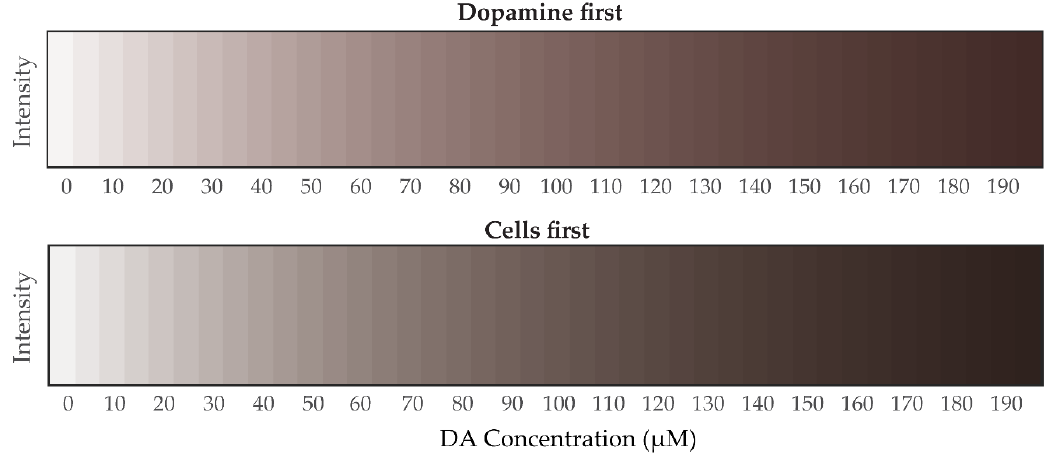
Figure 12. Projected RGB color intensities from the exponential model (5) for a wide range of dopamine concentrations (incremented by 5 µM) for both experiments: dopamine first ( top panel) and cells first ( bottom panel).